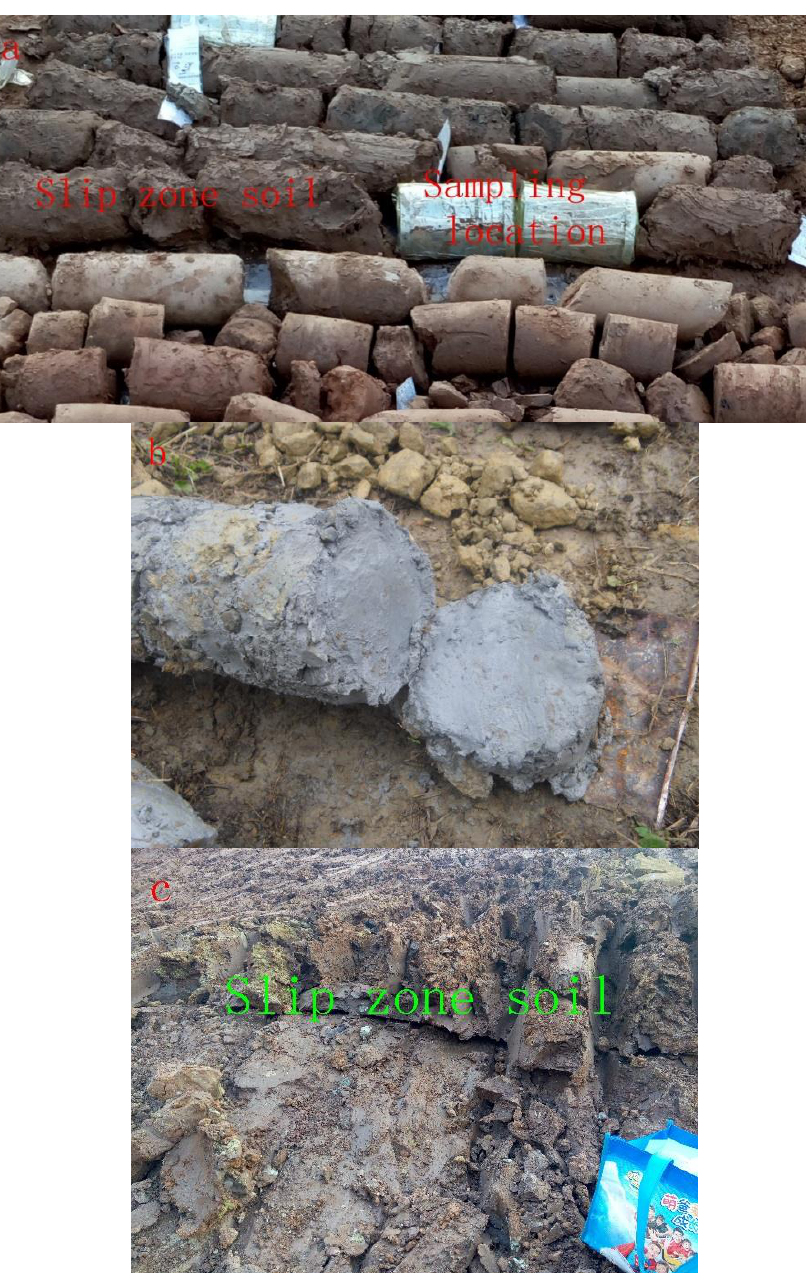
Figure 6. ( a ) ZK1-1 borehole sliding zone soil, ( b ) ZK2-2 drilling sliding surface soil, ( c ) sliding zone soil.